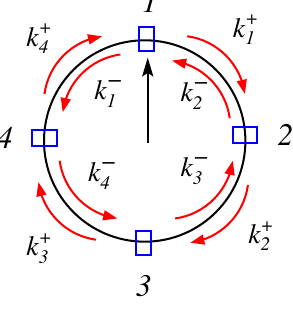
FIG. 1. Illustration of a Brownian clock with four states. The pointer in state 1 moves to state 2 with rate k þ 1 , or to state 4 with rate k − 1 , and so